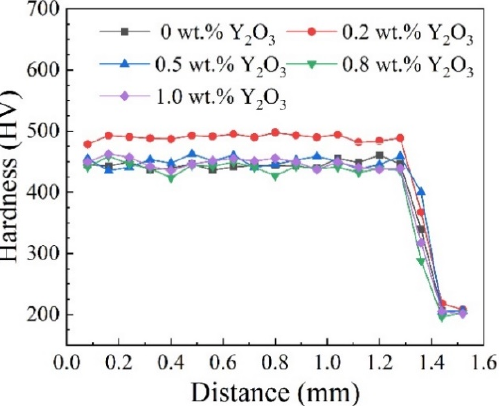
Figure 7. The effects of different Y 2 O 3 additions on the micro-hardness of coatings.